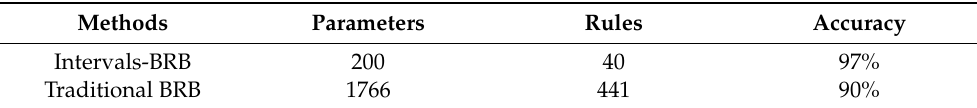
Table 14. Related metrics of the traditional BRB model and intervals-BRB model.